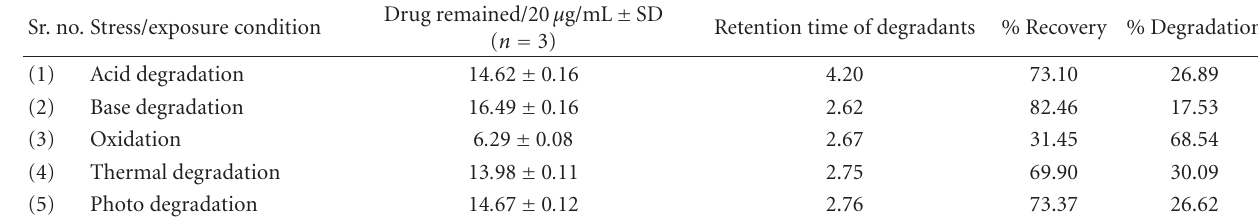
Table 4: Summary of forced degradation